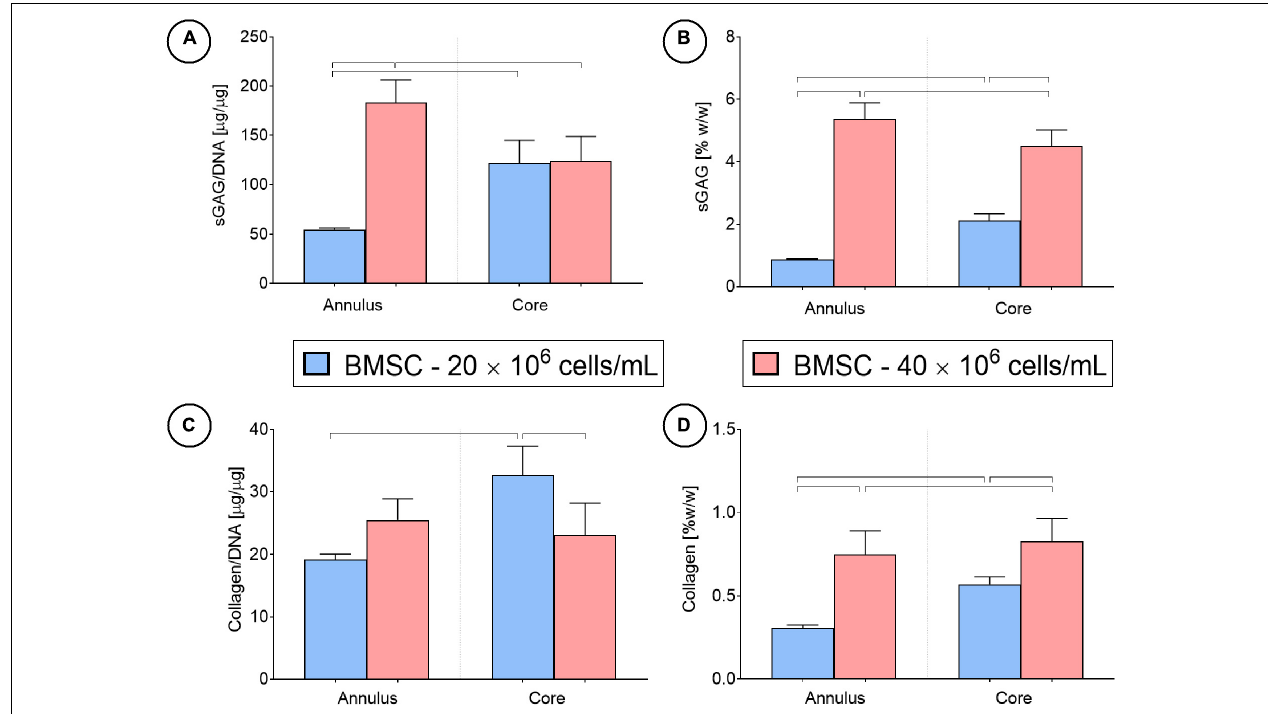
FIGURE 9 | Cartilage tissue grafts engineered using bone marrow MSCs were seeded initially at a density of either 20 or 40 million cells/mL for 24 days, then separated into cores and annuli and analyzed for DNA, sGAG and collagen content. Significant differences between groups are indicated where P < 0.05 ( n =